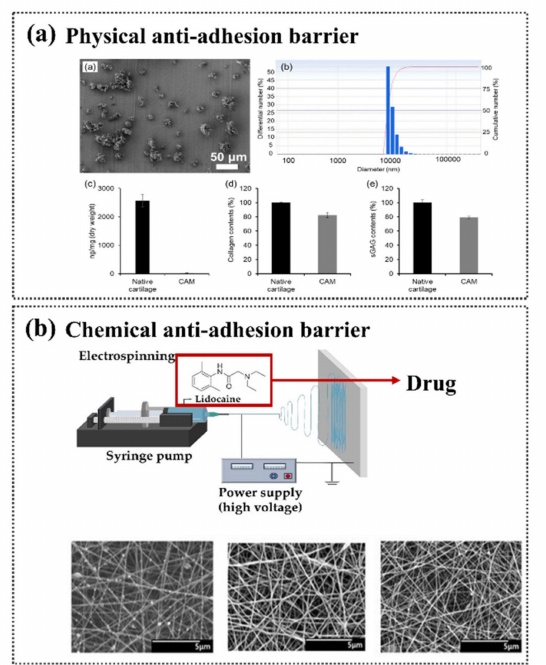
Figure 5. Physical and chemical anti-adhesion barrier: ( a ) Cross-linked cartilage acellular-matrix film [126]; ( b ) drug-loaded alginate / carboxymethyl cellulose (CMC) / polyethylene oxide (PEO) anti-adhesion film